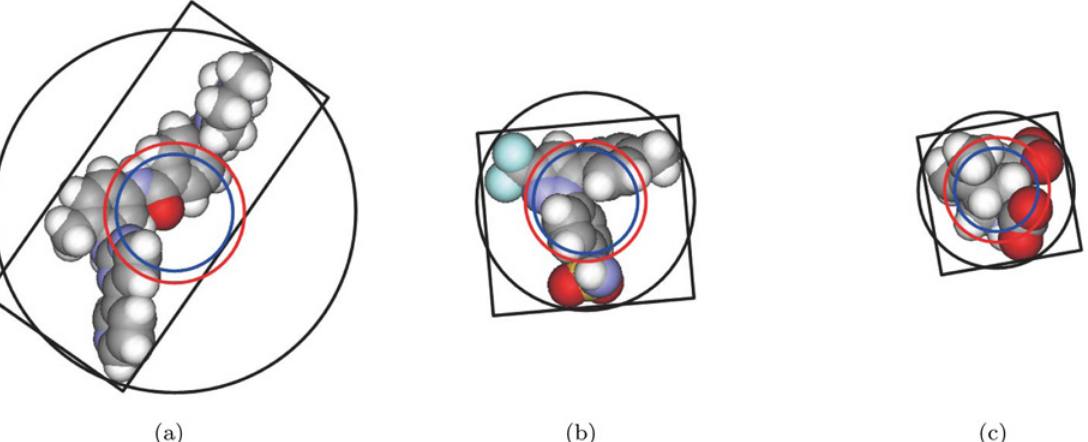
Fig 4. Some of the proposed L-descriptor types. The black circle denotes the minimum enclosing sphere; the red circle denotes the sphere whose volume is identical to the volume of the van der Waals model of the ligand; the blue circle denotes the sphere whose volume is identical to the volume of the beta- shape; the black rectangle denotes the bounding box of the PCA analysis. The PDB accession codes that contains the complex with the shown ligands are as follows: (a)1t46, (b)1oq5, and (c) 1tt1.